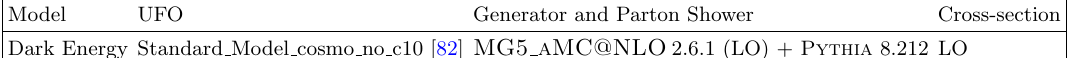
Table 6. Details of the generation setup and Universal FeynRules Output (UFO) model used for the dark energy